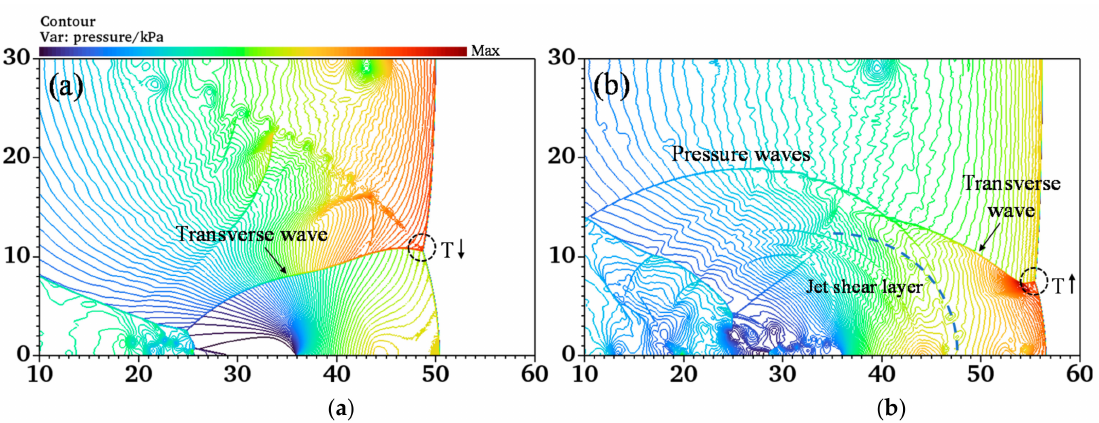
Figure 5. Pressure isolines showing the propagation of triple points in detonation initiation of a single-jet: ( a ) t = 215 µ s; ( b ) t = 240 µ